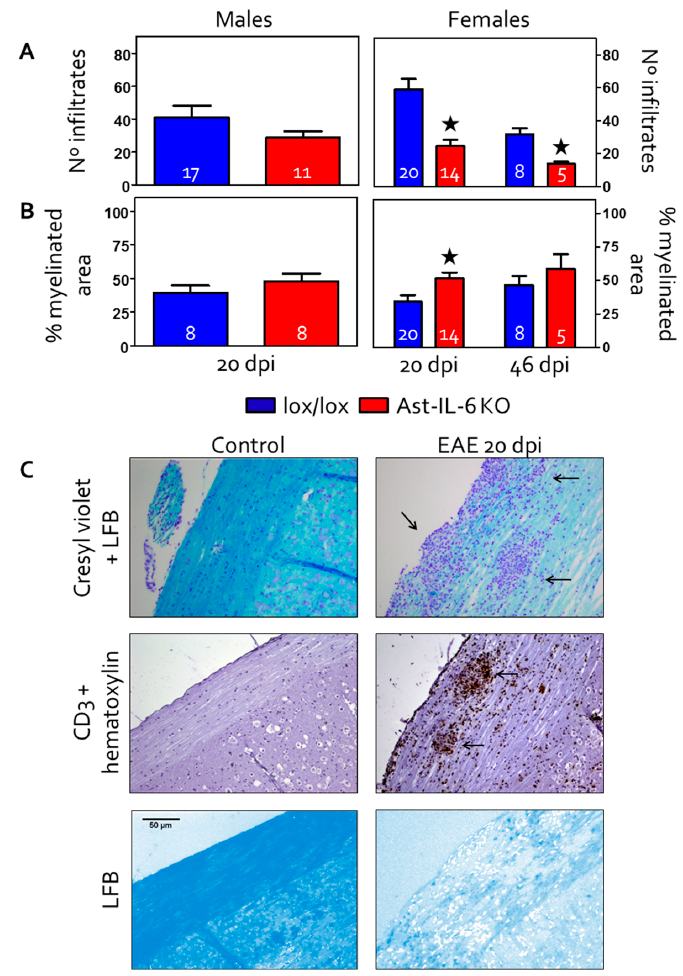
Figure 2. Assessment of the total number of cellular infiltrates ( A ) and demyelination ( B ) in the longitudinal lumbar-cervical spinal cord white matter from EAE-induced animals at 20 dpi (for both females and males Ast-IL6 KO and floxed mice) and 46 dpi (females). Number of mice per group as indicated. ★ p < 0.05 between Ast-IL6 KO and floxed mice. ( C ) Representative sections from female mice showing infiltrates (arrows) in spinal cord stained with Cresyl violet (top) and CD3 (middle) in non-immunized (control) and immunized (20 dpi) floxed mice. The bottom panel shows the demyelination of the spinal cord as revealed by Luxol Fast Blue (LFB) staining following color deconvolution. All images at magnification 100×.